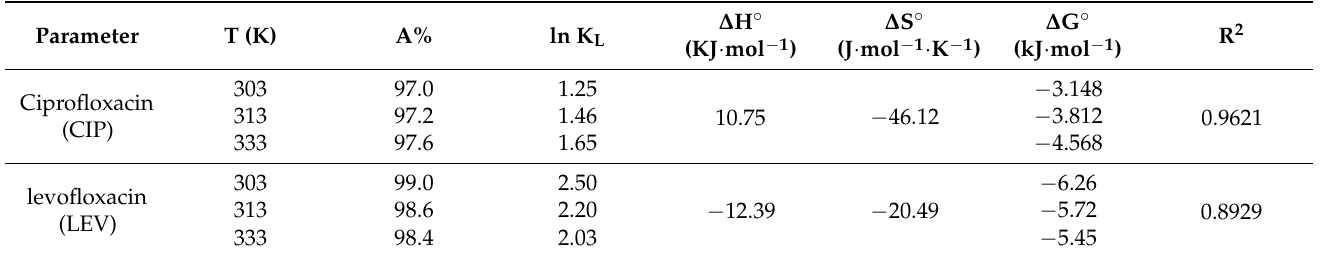
Table 5. Thermodynamic conditions using 0.2 g/25 mL of the nanocomposite at pH 6 for CIP (10 ppm) and 7 for LEV (20 ppm), with contact times of 40 min and 45 min for CIP and LEV, respectively.